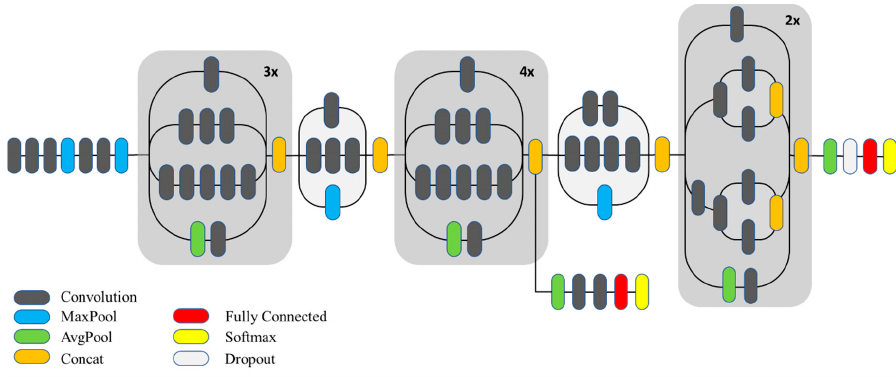
Figure 6. Inception-v3 architecture.